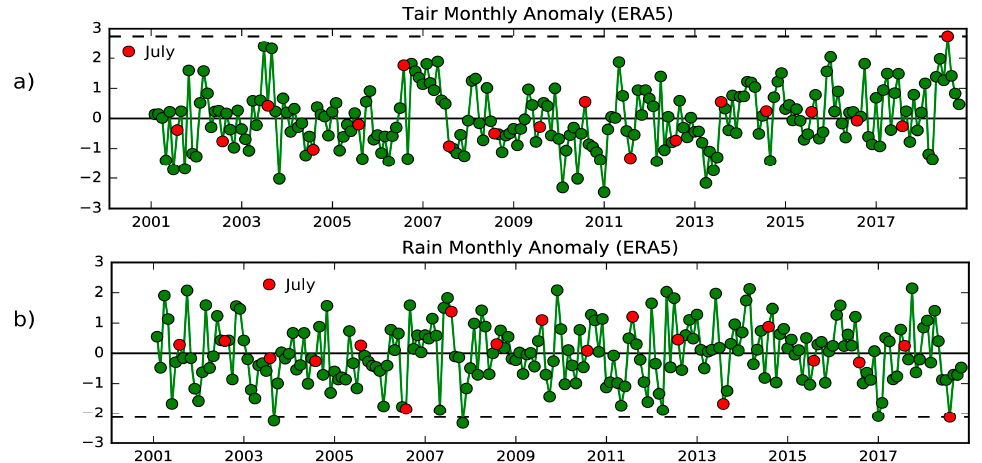
Figure 3. Monthly Anomaly time-series (scaled by the standard deviation, expressed in units of standard deviation) of air temperature ( a ) and precipitations ( b ) from ERA5 atmospheric reanalysis dataset over January 2001–October 2018. Months of July are highlighted in red, straight dashed lines represent values for July 2018.